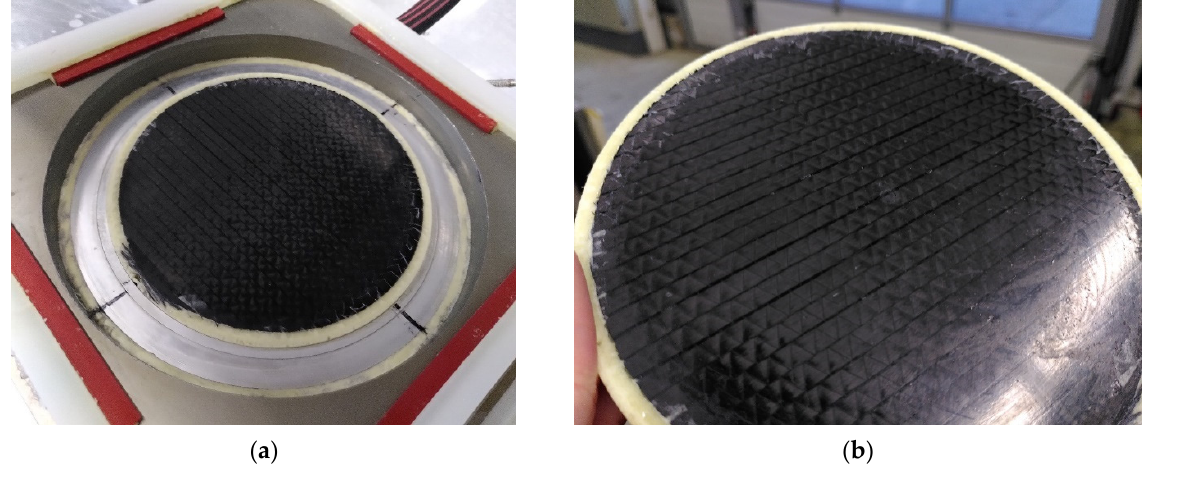
Figure 4. D-SCM sandwich structures: in the lower cavity after mold opening ( a ); demolded, cured sandwich component ( b